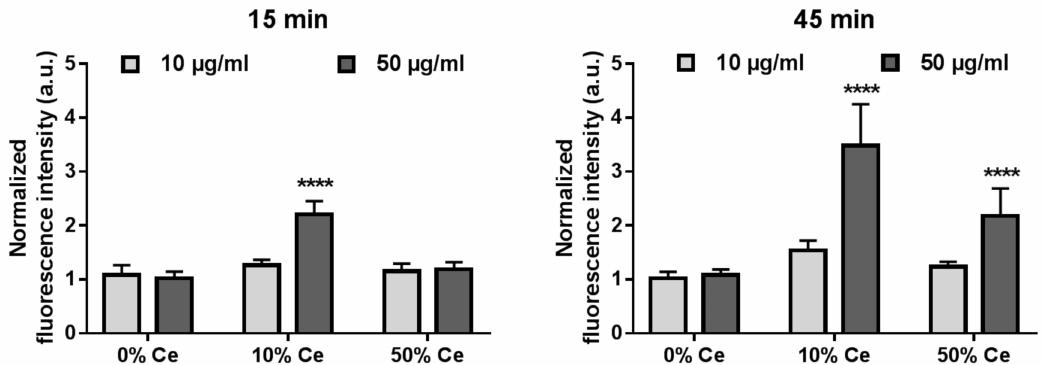
Figure 6. Intracellular ROS production of RAW 264.7 cells upon exposure to 10 and 50 µ g/mL of Gd 2(1 − x ) Ce x O 2 S nanoparticles (0, 10 and 50% Ce) after 15 min and 45 min. The ROS production was normalized to that of unexposed cells. The experiments were repeated three times. **** indicates a p -value inferior to 0.0001. Following exposure to 10 µ g/mL of Gd 2(1 − x ) Ce 2 x O 2 S nanoparticles during 15 min,